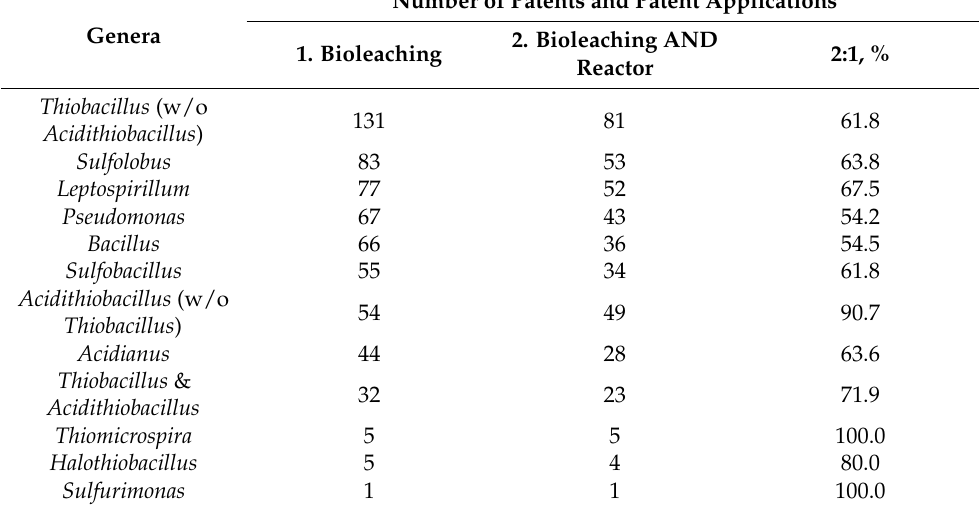
Table 2. Number of the US patents and patent applications (1988–2022) found by keywords “bioleach- ing” or “bioleaching AND reactor” together with the generic names of microorganisms in the US patent databases US-PGPUB, USPAT, USOCR.